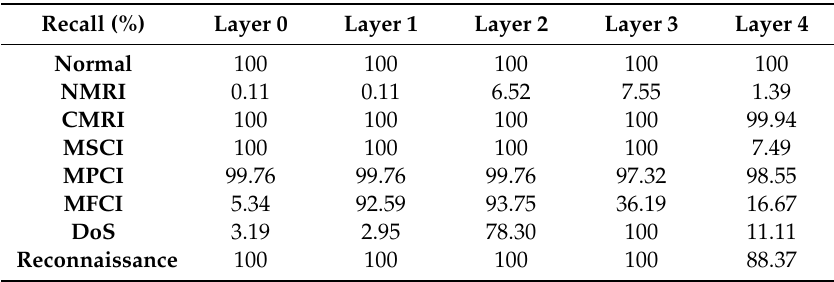
Table 2. Recall of the clustering results of each class in each hidden